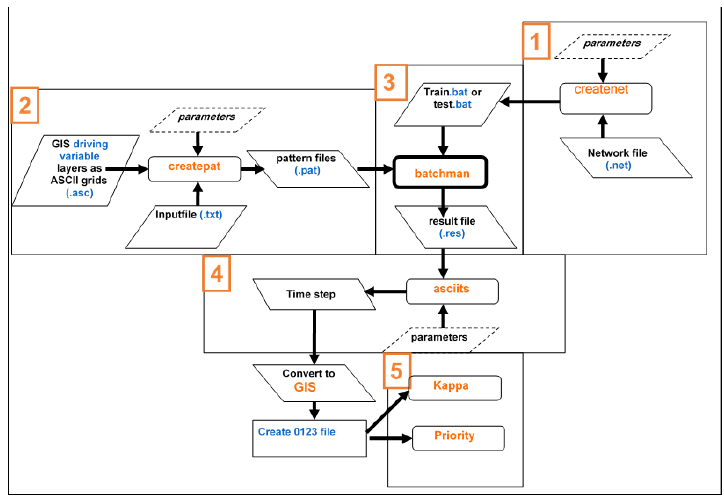
Figure 8. Breakdown of LTM Steps. 1. Create network file: In this step, the drivers prepare for